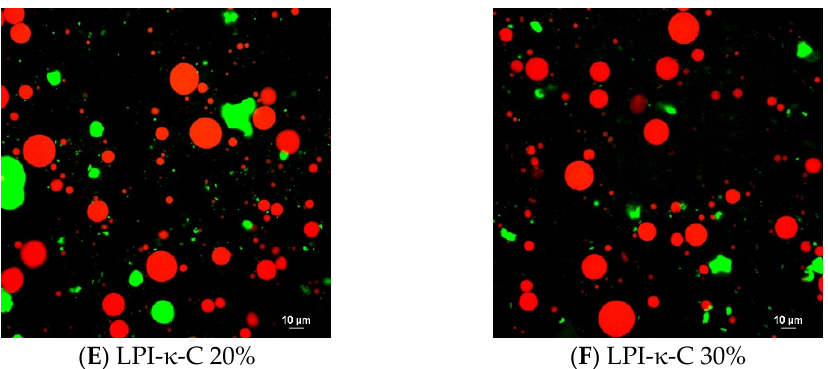
Figure 1. Confocal laser scanning microscopy (CLSM) images of oil-in-water emulsions for systems of LPI 20% and 30% (( A , B ), respectively), LPI- ι -carrageenan (LPI- ι -C) 20% and 30% (( C , D ), respectively), and LPI- κ -carrageenan (LPI- κ -C) 20% and 30% (( E , F ), respectively). Red color represents oil droplets, and green color represents proteins. All the scale bars represent 10 µ. The percentage on the name of the samples represents the final oil content in dried powders.